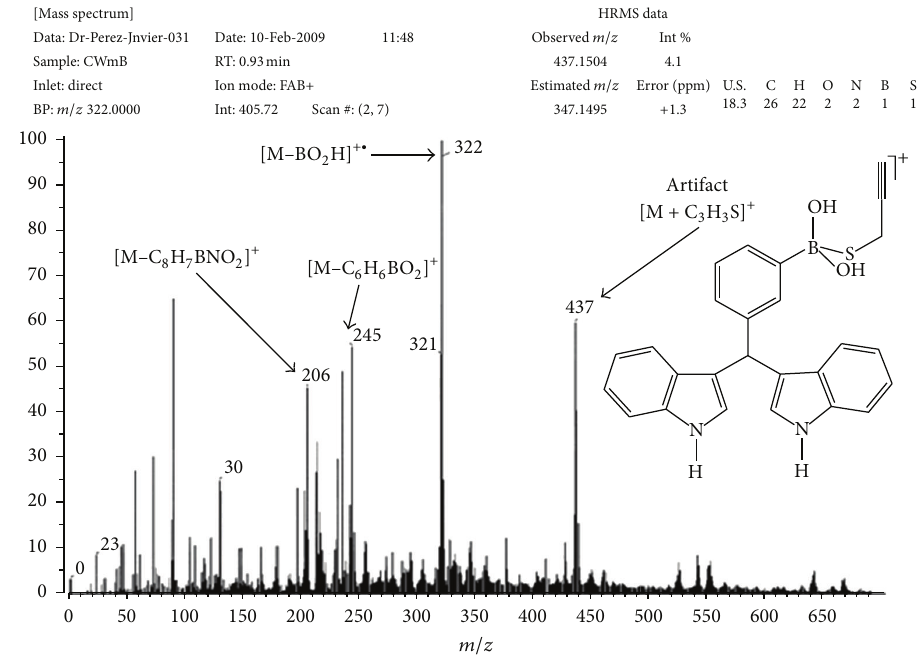
Figure 3: FAB + mass spectra and accurate mass data of adduct from 6